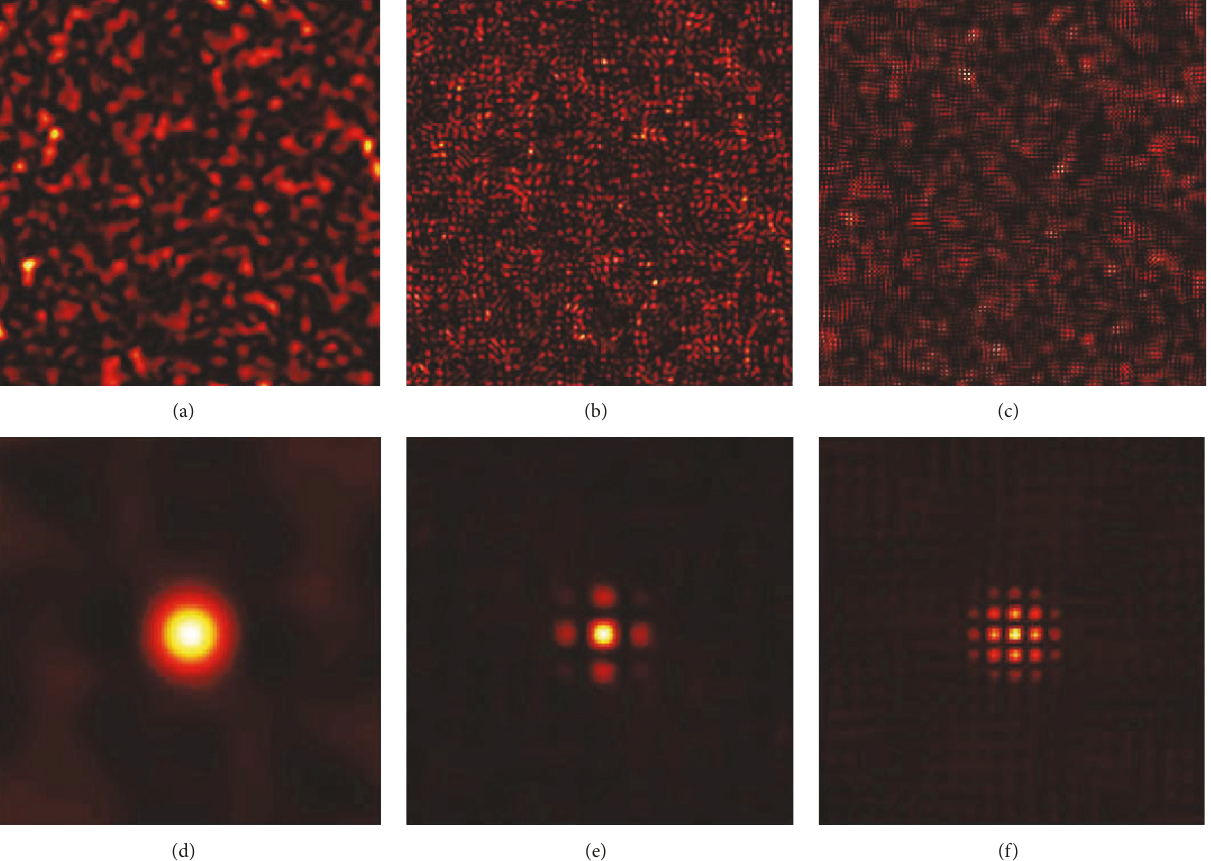
Figure 1: The simulation of speckle pattern in the source plane for different 𝑛 with 𝛿 = 6 mm, (a) 𝑛 = 0 , (b) 𝑛 = 1 , and (c) 𝑛 = 2 and the autocorrelation corresponding to the speckle pattern, (d) 𝑛 = 0 , (e) 𝑛 = 1 , and (f) 𝑛 = 2